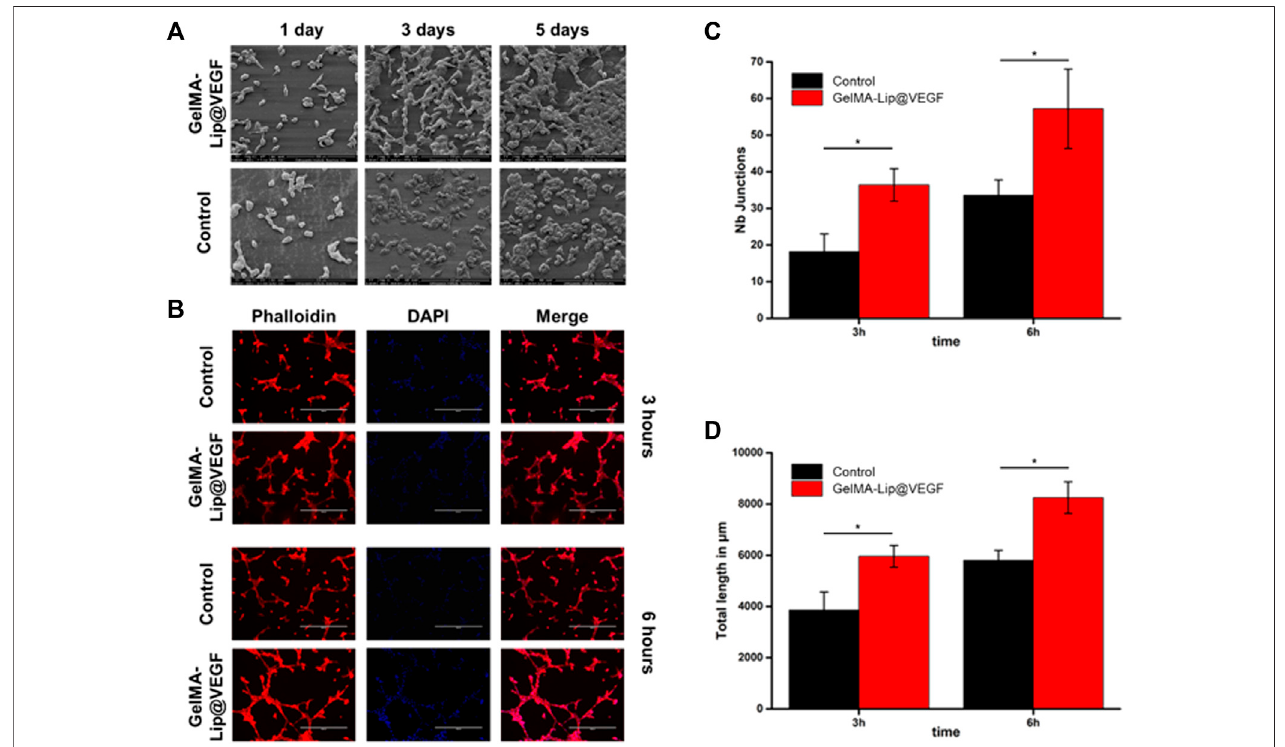
FIGURE 8 | Characterization of the angiogenic activity. (A) SEM observation of HUVECs seeded on hydrogels. (B) Phalloidin and DAPI staining of HUVECs on hydrogels. (C) Quanti fi cation of the number of junctions. (D) Quanti fi cation of the tube length.